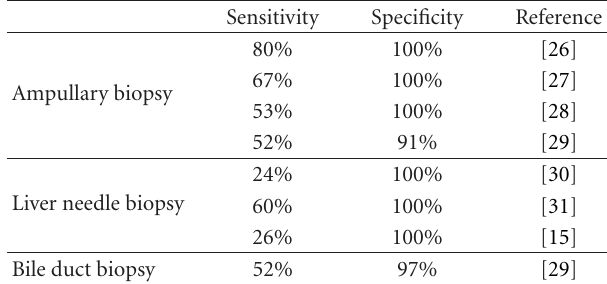
Table 2: Sensitivity and specificity of detection of IgG4 + plasma cells ( ≥ 10 cells/high power field) by ampullary, liver, and bile duct